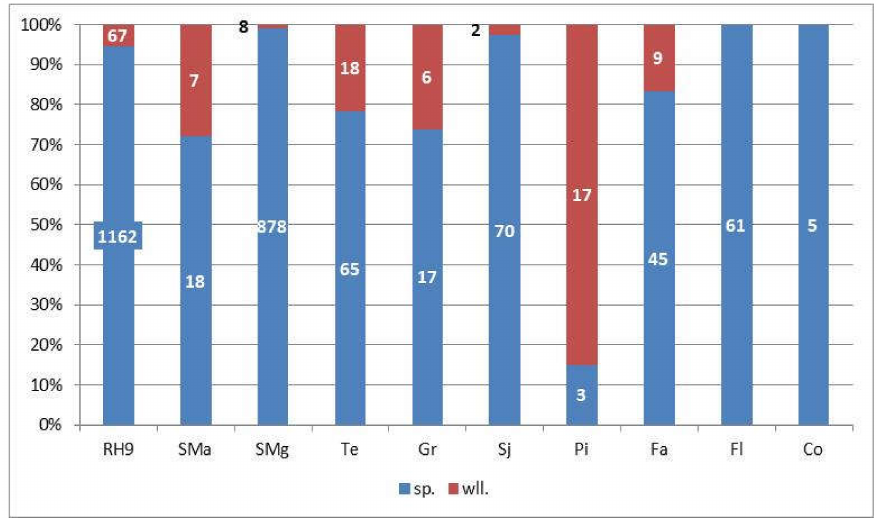
Figure 5. Number of springs and wells used for water supply in the Azores archipelago (sp.: springs; wll.: drilled